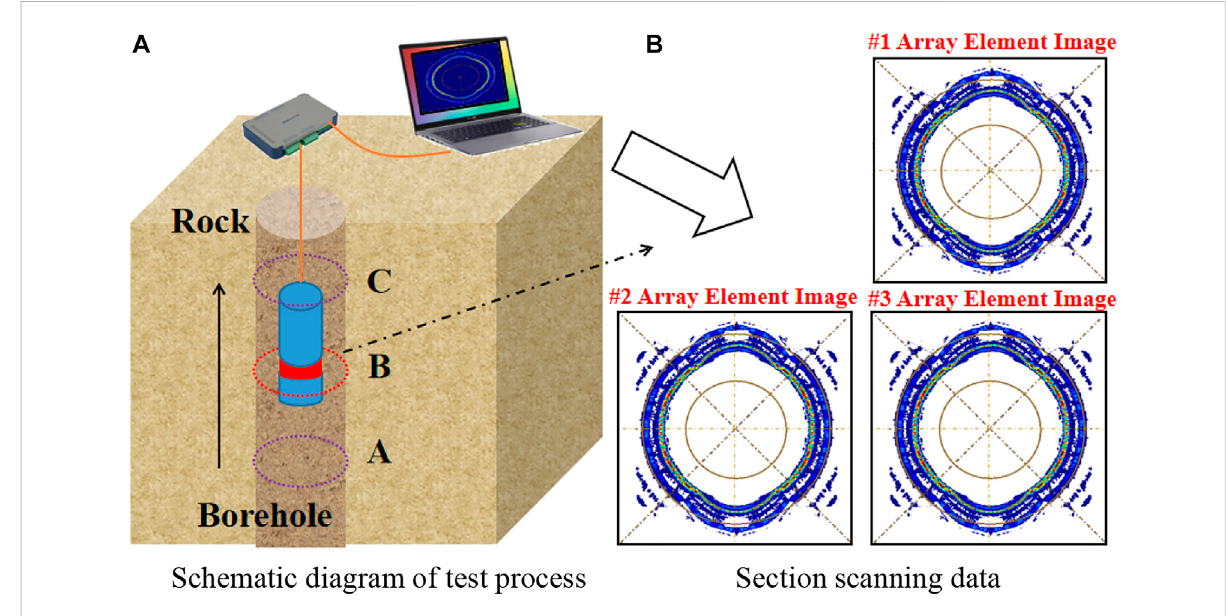
FIGURE 8 Test process and scanned image.